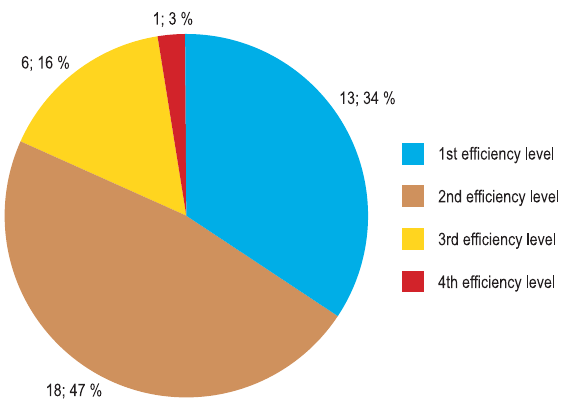
Fig. 8 . Internal audit effi ciency level in Lithuanian